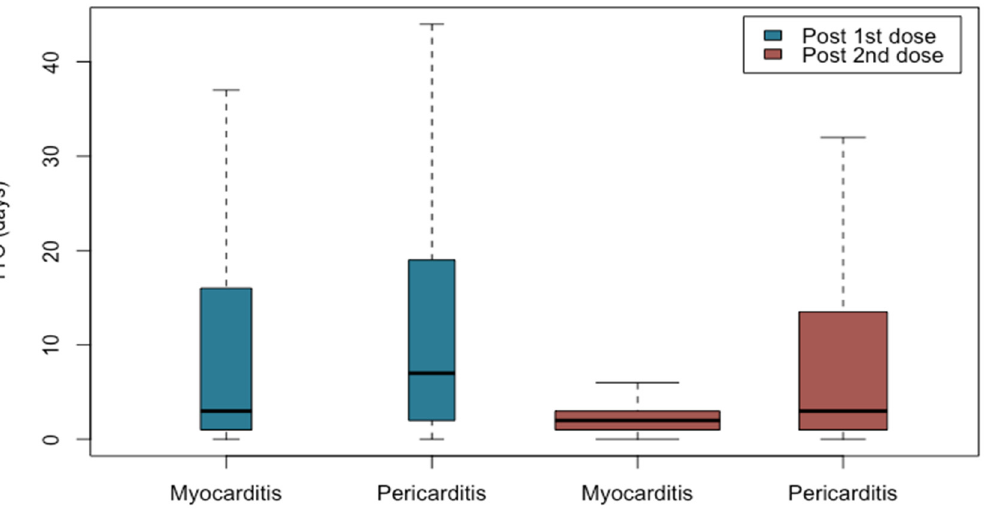
Figure 3. Boxplot—time to onset of myocarditis and pericarditis followed by the first and second dose of mRNA COVID-19 vaccines.